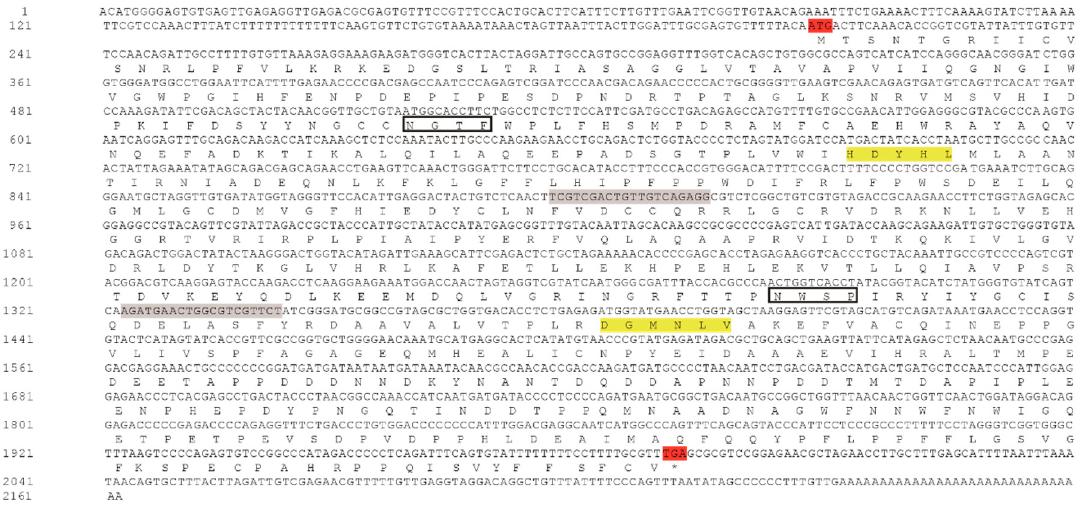
Figure 1. Nucleotide and deduced amino acid sequences of DcTPS from D. citri . Both initiation codon and termination codon are shaded in red. Motifs (or signature motifs) unique to trehalose-6-phosphate synthase (TPS) (residues 450–464 and 555–567) are shaded in yellow. Two glycosylation sites are indicated in black box. The primer sequences used for synthesis of dsRNA are shaded in gray.